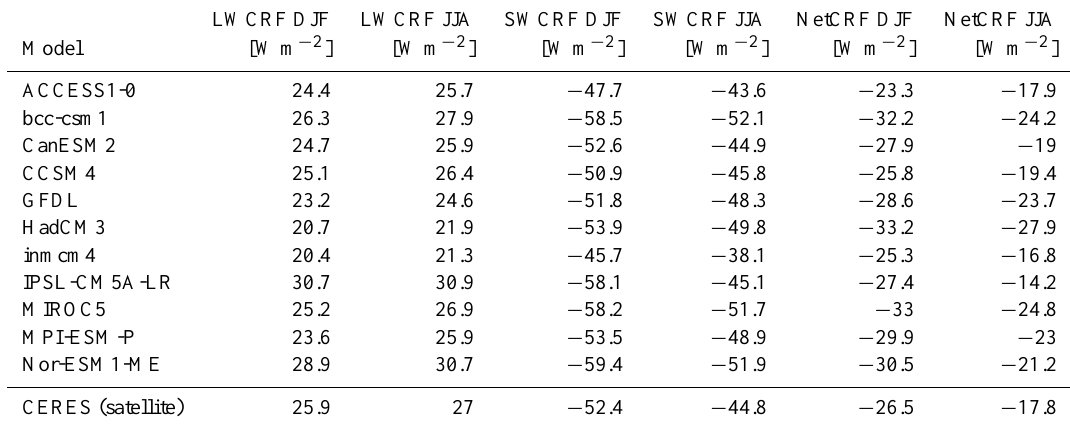
Table 2. Global mean LWCRF, SWCRF, and NetCRF for DJF and JJA for several CMIP5 models as well as for CERES satellite data averaged over 10